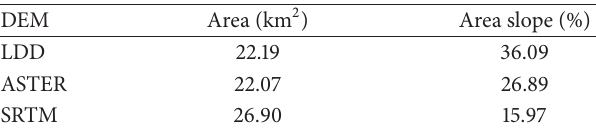
Table 3: Sizes of areas extracted from DEMs of Huai-Sai-Khaw